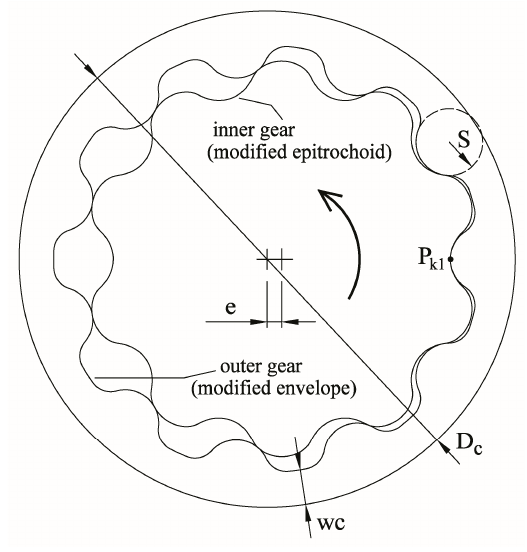
Figure 1. Basic geometrical parameters of the trochoidal-gear set.